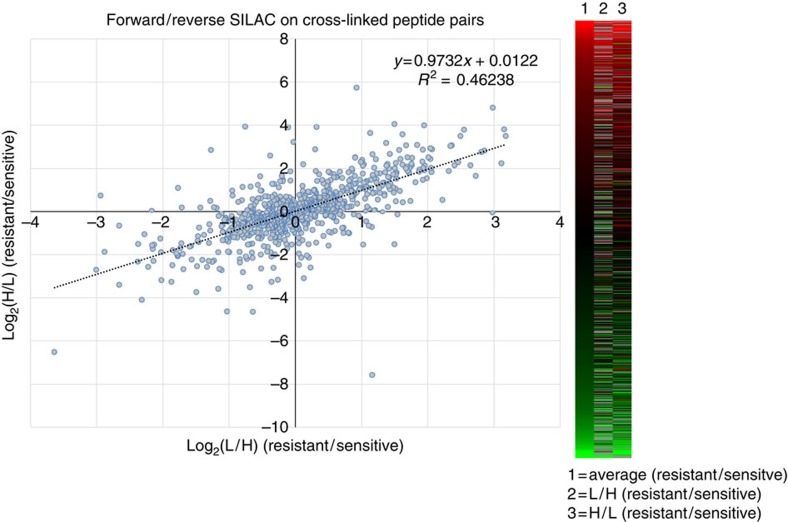
Quantitative reproducibility of crosslinked peptides.Scatterplot of log2(light/heavy) versus log2(heavy/light) values for n=767 crosslinked peptide pairs out of 1,166 total (66%). Those that were only observed in forward or reverse SILAC experiments were omitted from the scatterplot but can be seen as grey entries in the heatmap.